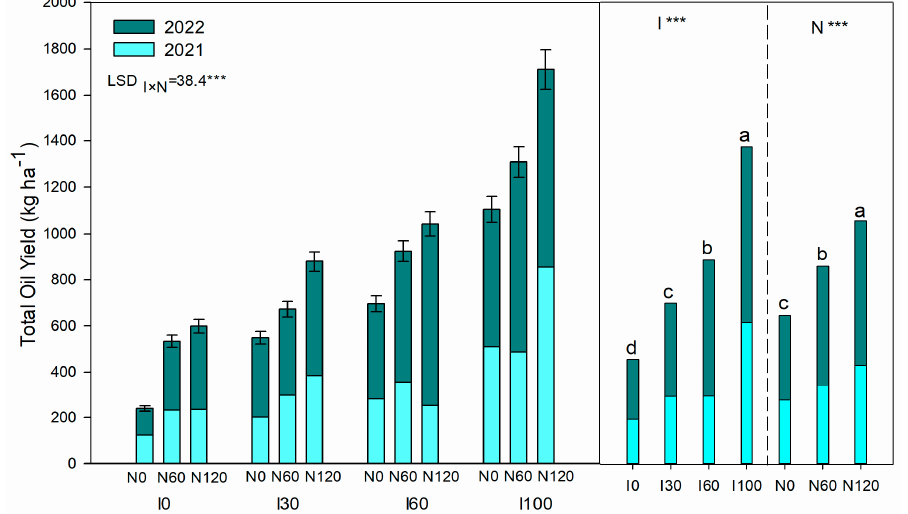
Figure 4. On the left, the total oil yield (kg ha − 1 ) of the two years (2021 and 2022) in relation to irrigation (I0, I30, I60, and I00 = 0, 30, 60, and 100% ETm, respectively) and N fertilization (N0, N60, and N120 = 0, 60, and 120 kg ha − 1 N), with error bars indicating the standard error. On the right, there is the mean separation of the total oil yield, with different letters representing statistically significant means according to the LSD test ( p ≤ 0.05). The significance levels of the ANOVA for irrigation and N fertilization (*** significant at p ≤ 0.001) and a significant interaction (LSD I × N at p ≤ 0.05) are shown.